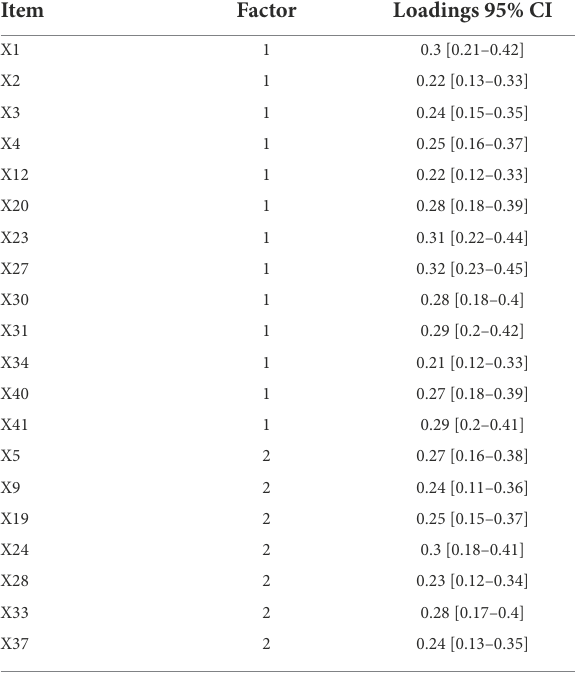
TABLE 3 BEFA 95% HDI cross-loading on identified factors.